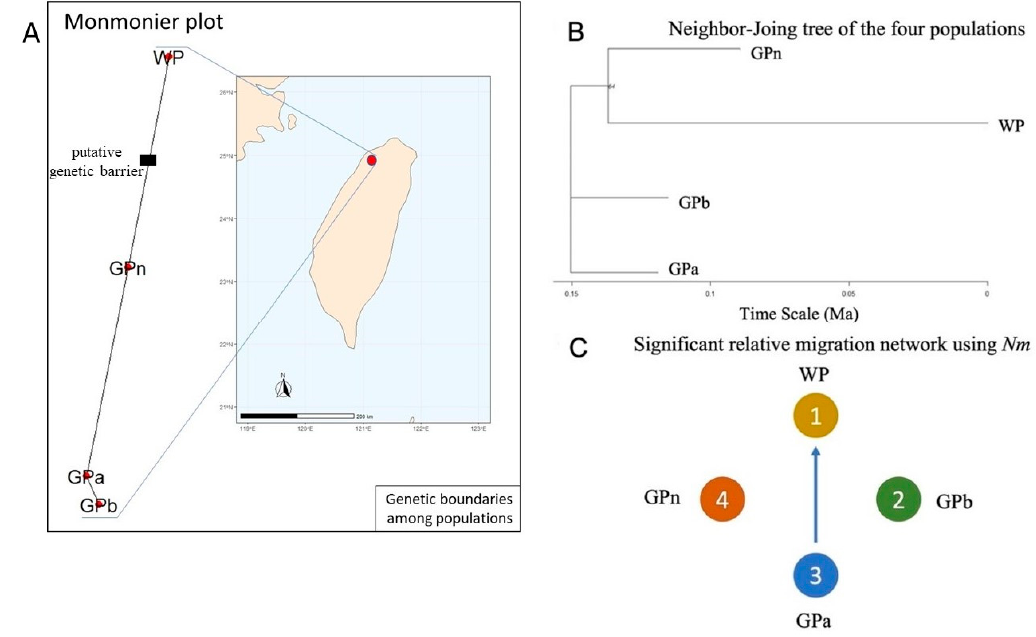
Figure 6. The genetic relationships of N. shimadai populations in northern Taiwan: ( A ) the genetic barrier (black square) in the Monmonier plot was detected between the WP population and the others, ( B ) the phylogram according to time scale (in Ma) by the Neighbor-Joining method based on 39 microsatellite loci (bootstrap = 1000), and ( C ) a significant ( p < 0.05) migration was detected from the GPa to the WP population based on Nm indicated by the blue arrow. The divMigrate filter threshold function at 0.5 for asymmetric values and bootstrap = 1000 were applied.